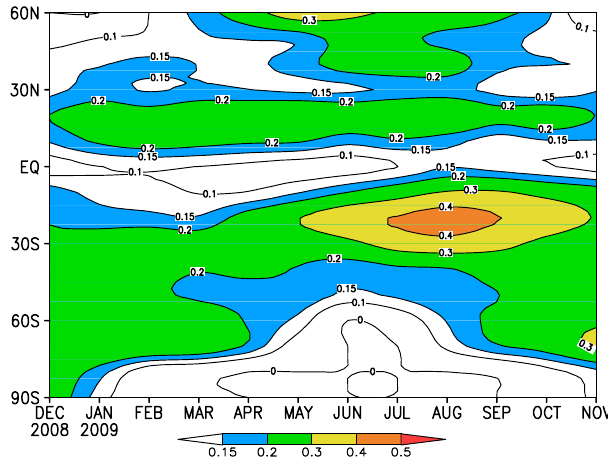
Figure 9. Average longitudinal distribution of stratiform clouds and their temporal evolution from December 2008 to November 2009, unit: